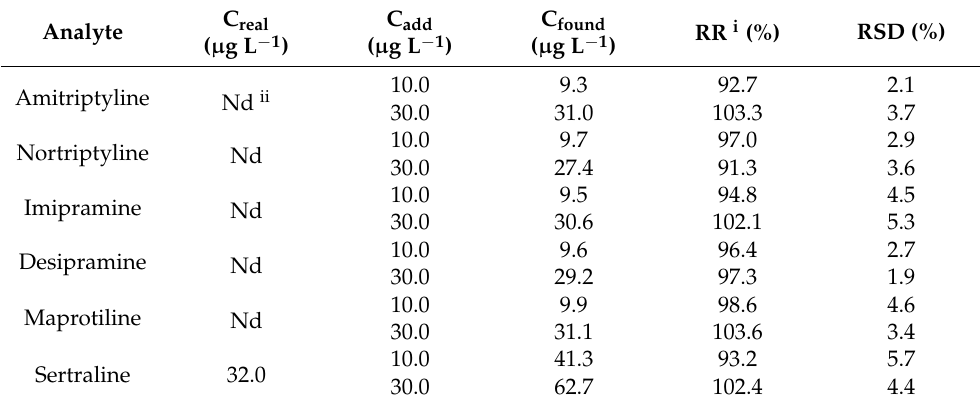
Table 3. Obtained results from the determination of TCAs in human bone marrow aspirate sample spiked at two different concentration levels.